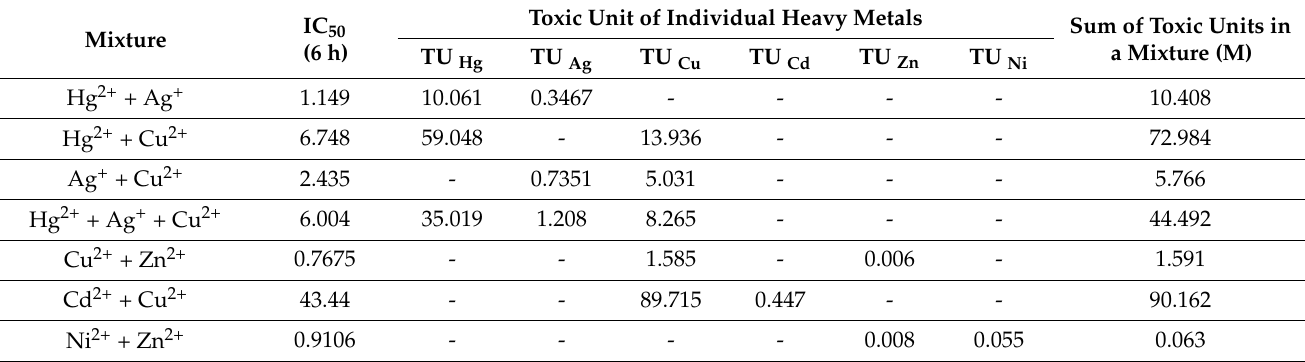
Table 6. List of Toxic Unit (TU) for each heavy metal in chronic toxicity test and sum of the toxic units, M in mixtures of heavy metals on Photobacterium sp.NAA-MIE.